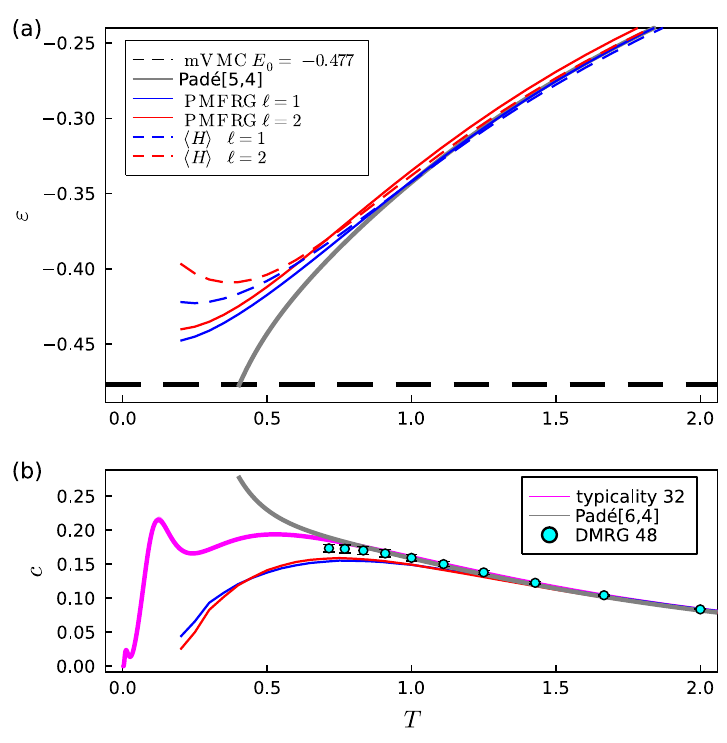
Figure 5: Energy per site (a) and specific heat capacity (b) as a function of temper- ature for one-loop ( (cid:96) = 1) in blue and two-loop ( (cid:96) = 2) in red. An estimate of the energy per site within PMFRG is accessible either from a derivative of the free en- ergy (solid), Eq. (2a), or through the expectation value of H in terms of equal time spin-correlators (dashed), Eq. (4). Additionally shown is the ground state energy estimate from mVMC [ 43 ] and the specific heat capacity from DMRG and canonical typicality on a 48- and 32-site cluster, respectively [ 44 ]